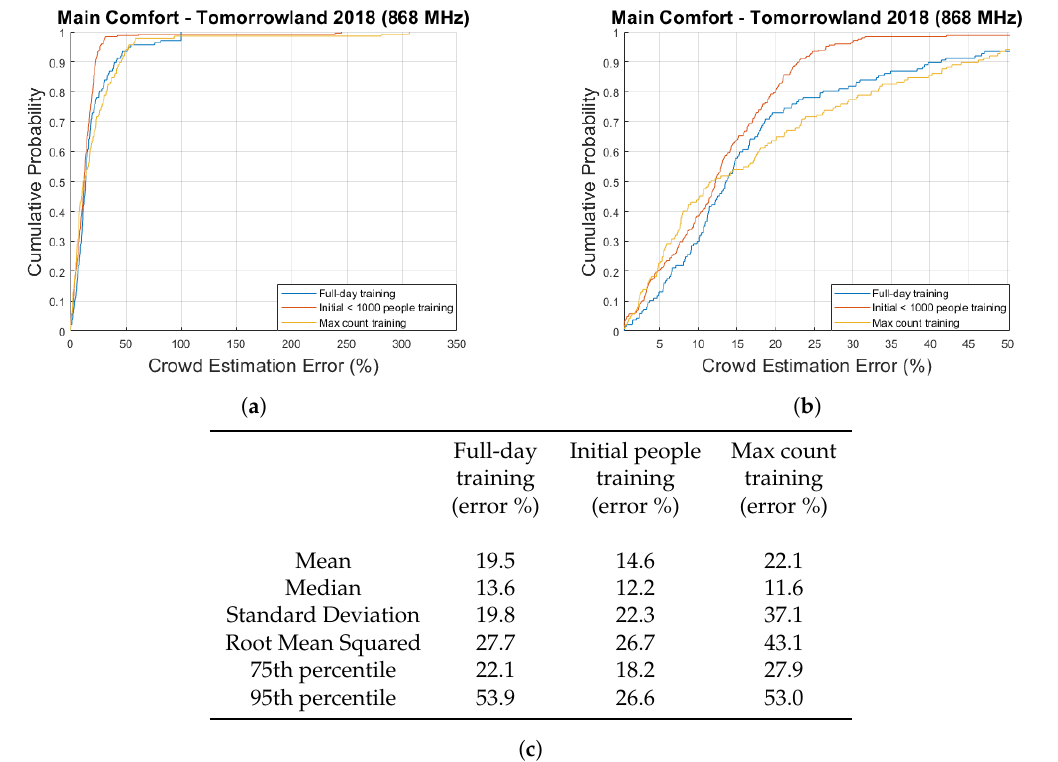
Figure 11. A cumulative distribution function plot comparing the obtained crowd estimation error value percentages for the Main Comfort data for three different training approaches. ( b ) zooms in on a portion of ( a ) and the table shown in ( c ) contains several key statistical parameters.